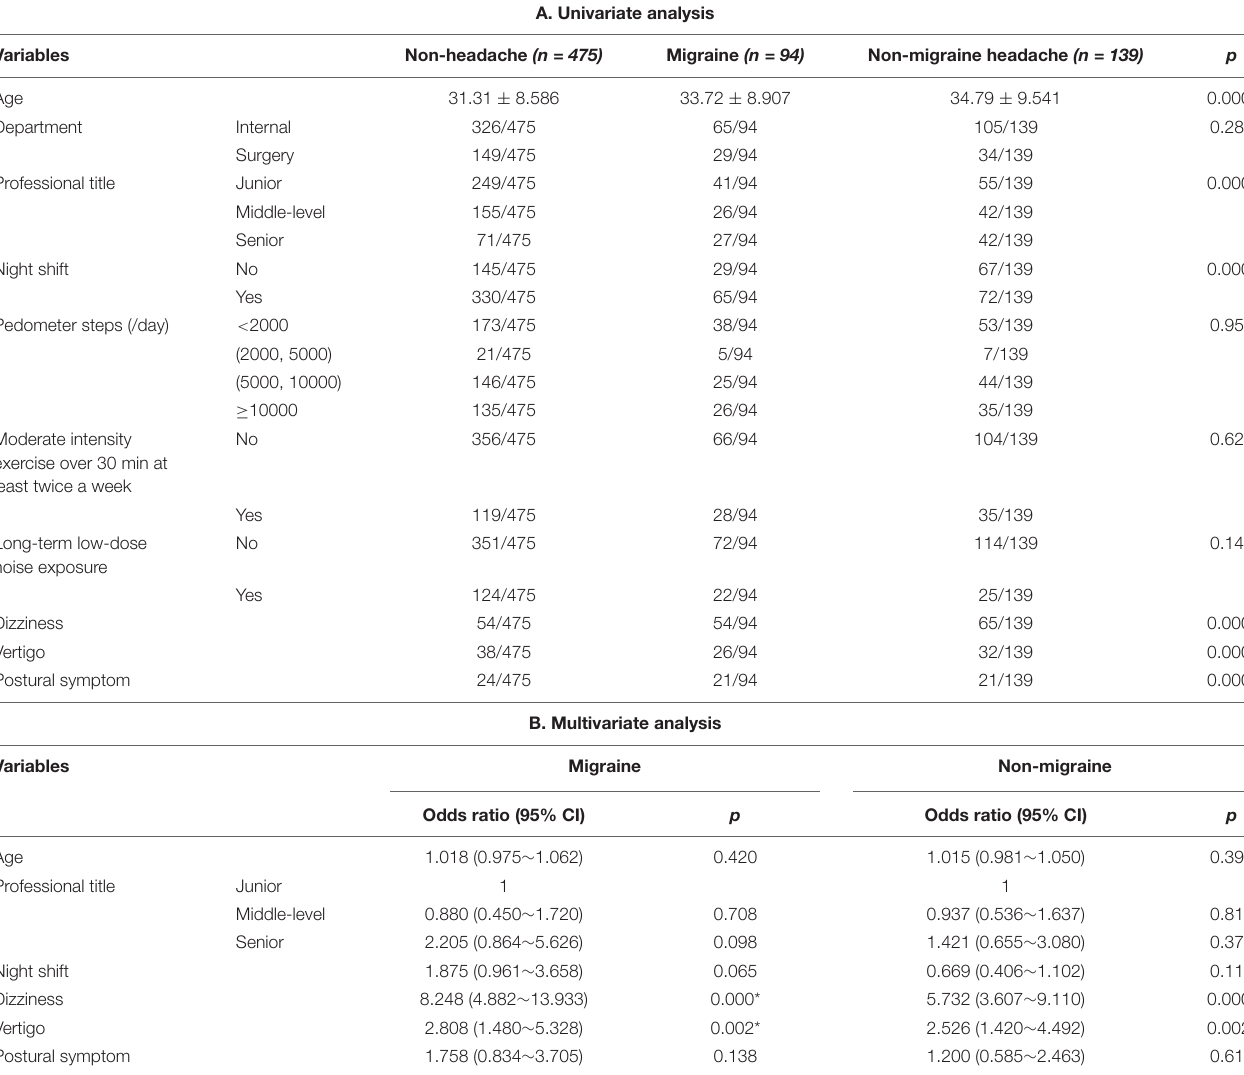
TABLE 2 | Factors related to migraine and non-migraine